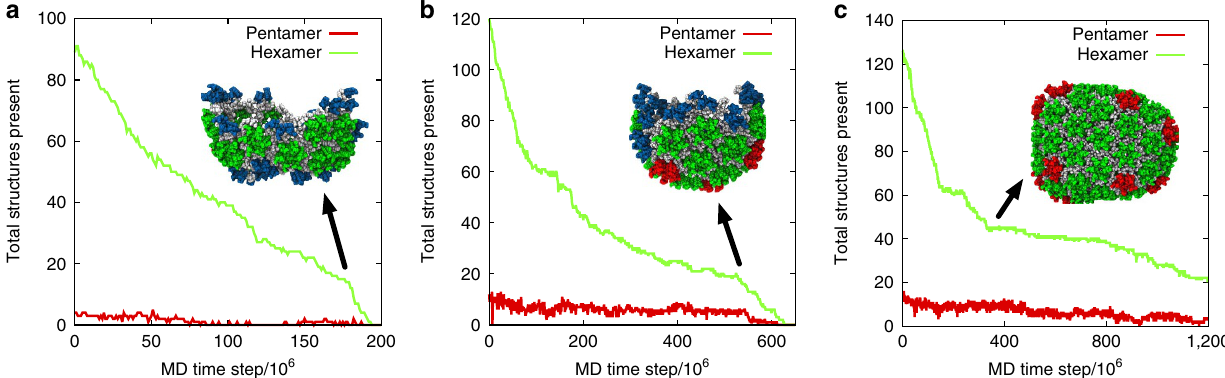
Figure 7 | Disassembly of self-assembled CG CA lattice under simulated rapid dilution with constant molecular crowding. Conformational switching intervals of 1 (cid:3) 10 4 time steps ( a ), 1 (cid:3) 10 5 time steps ( b ) and 5 (cid:3) 10 5 time steps ( c ) are shown. Simulation snapshots (inset) correspond to the systems at E 175 (cid:3) 10 6 ( a ), E 550 (cid:3) 10 6 ( b ) and E 350 (cid:3) 10 6 ( c ) CG MD time steps. Colour scheme as in Fig.